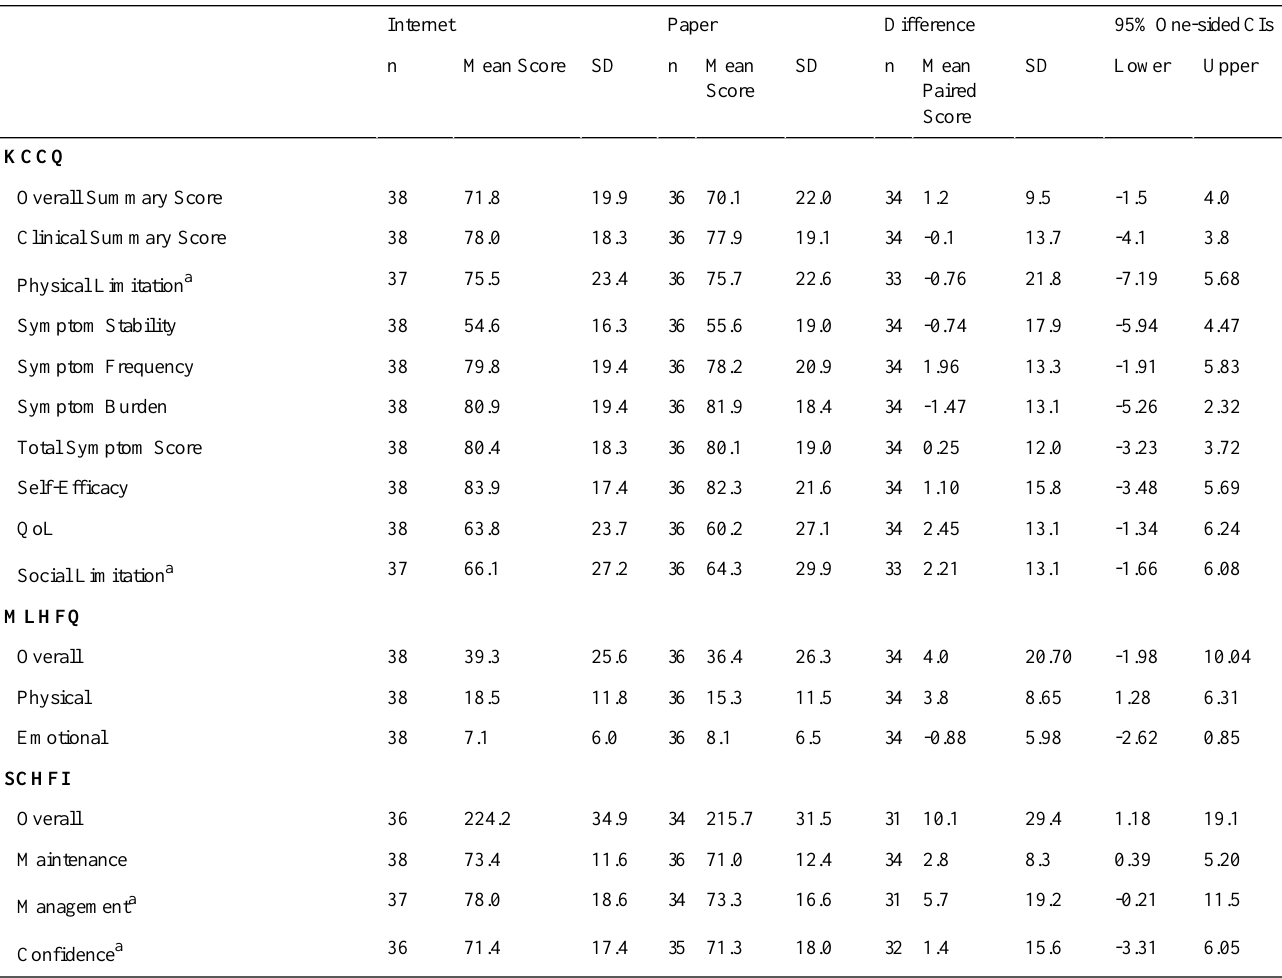
Table 2. Paired differences and one-sided confidence intervals for the overall and sub-domain scores for the three questionnaires